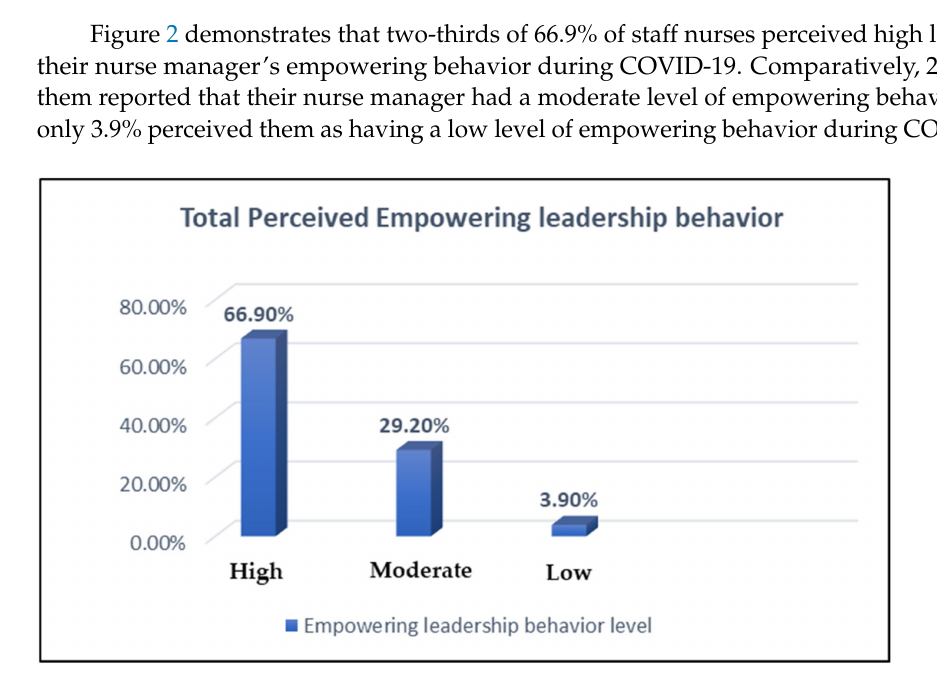
Figure 2. Total empowering leadership behavior levels as perceived by staff nurses ( n = 284).